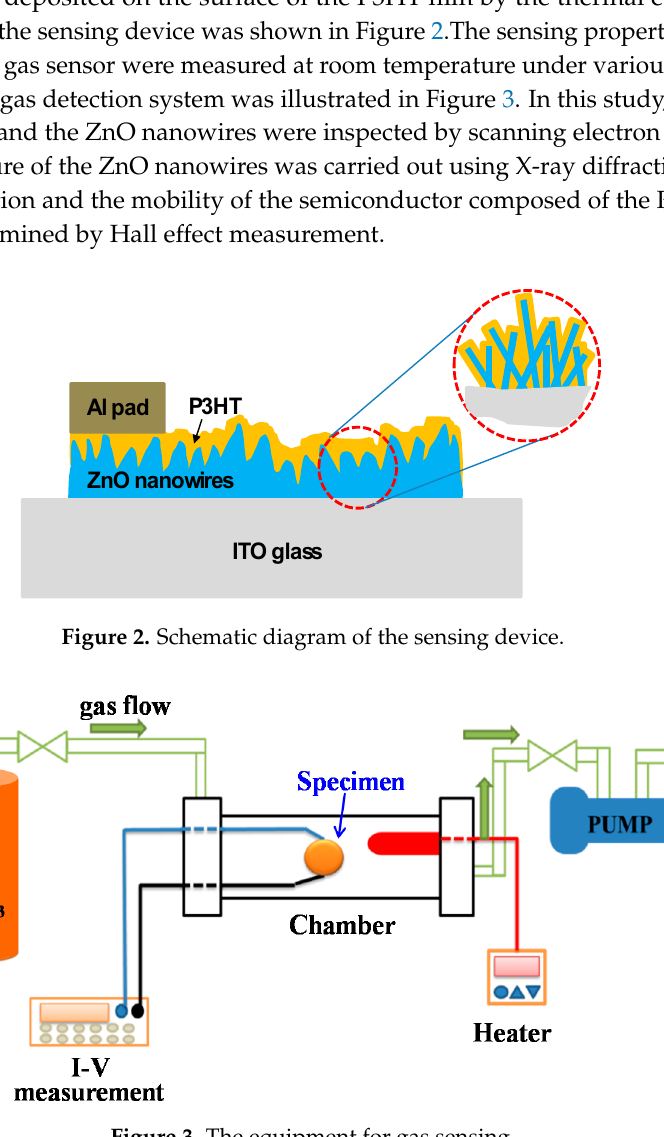
Figure 3. The equipment for gas sensing.